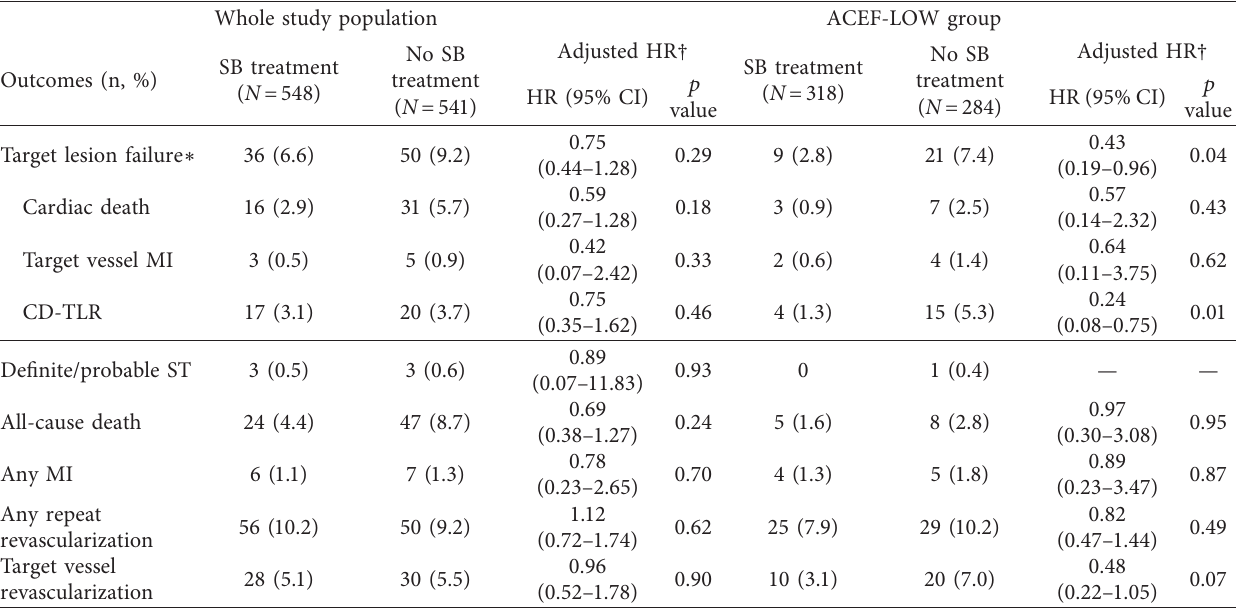
Table 3: Three-year composite and individual outcomes according to SB